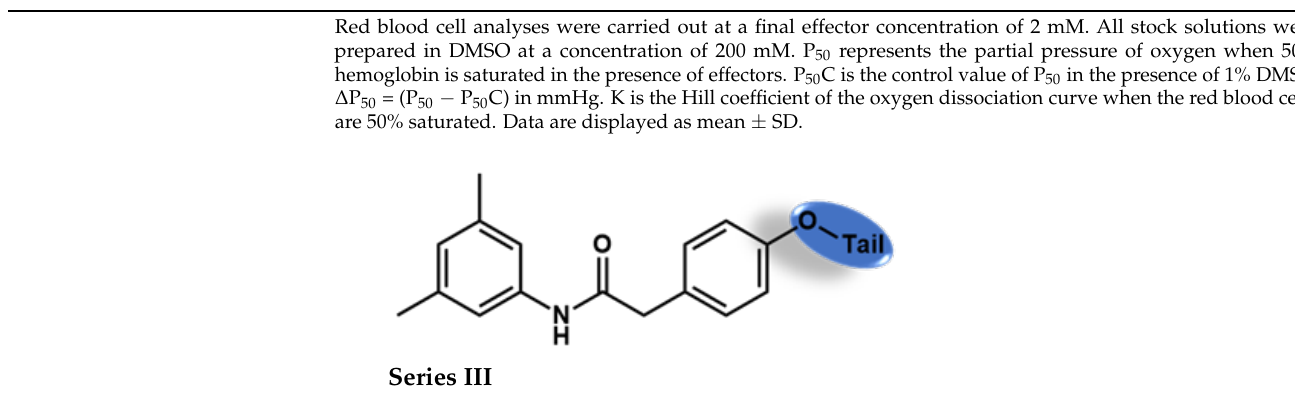
Table 3. Results of in vitro red blood cell studies.